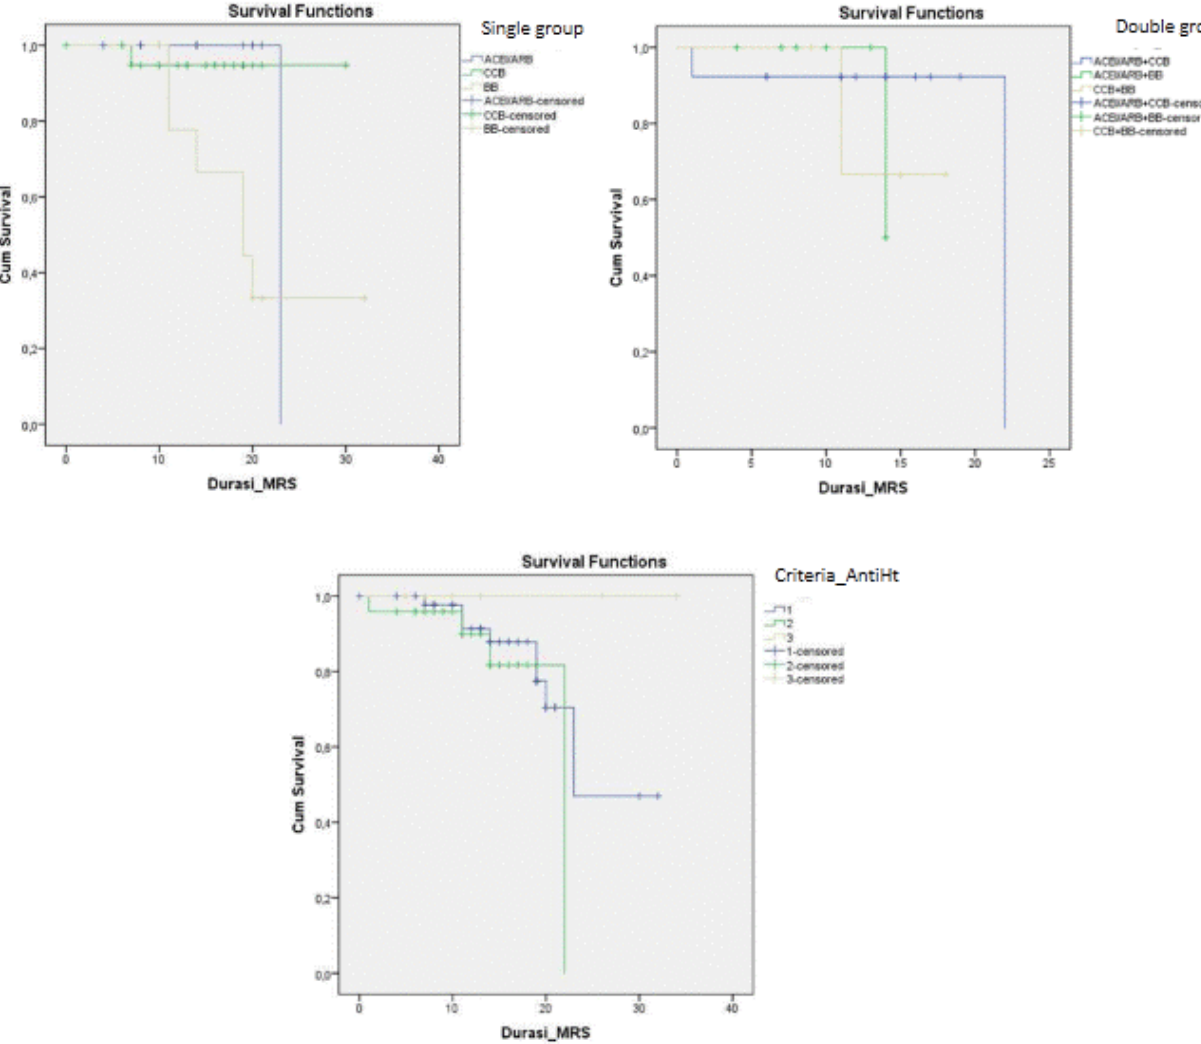
Figure 3. Time survival in 30 days among antihypertensive drugs. ACEI/ARB: angiotensin-converting enzyme inhibitors and angiotensin receptor blockers; CCB: calcium channel blocker; BB: beta blocker.